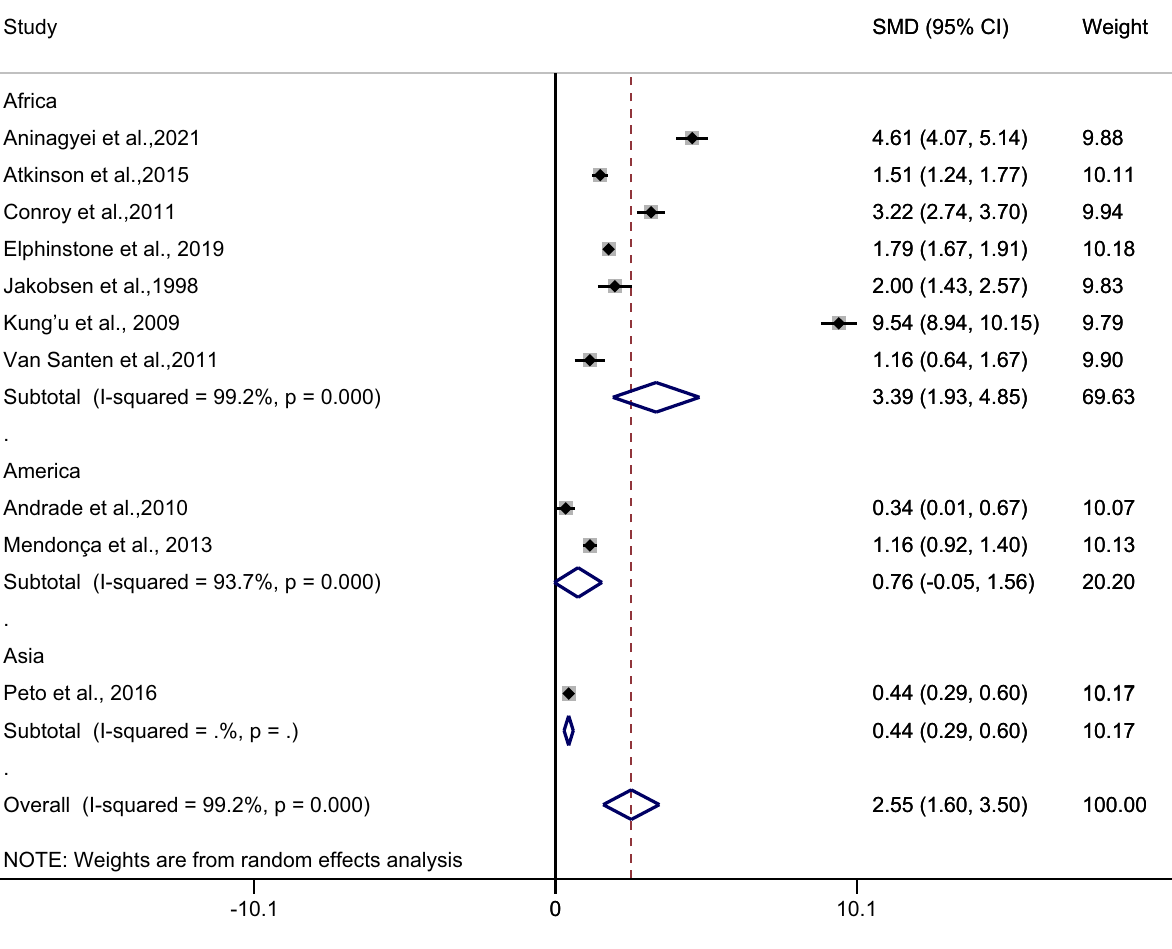
Figure 10. Forest plot demonstrates the difference in the mean CRP level between patients with asymptomatic malaria and healthy/febrile controls by continents. SMD, standard mean difference; CI, confidence